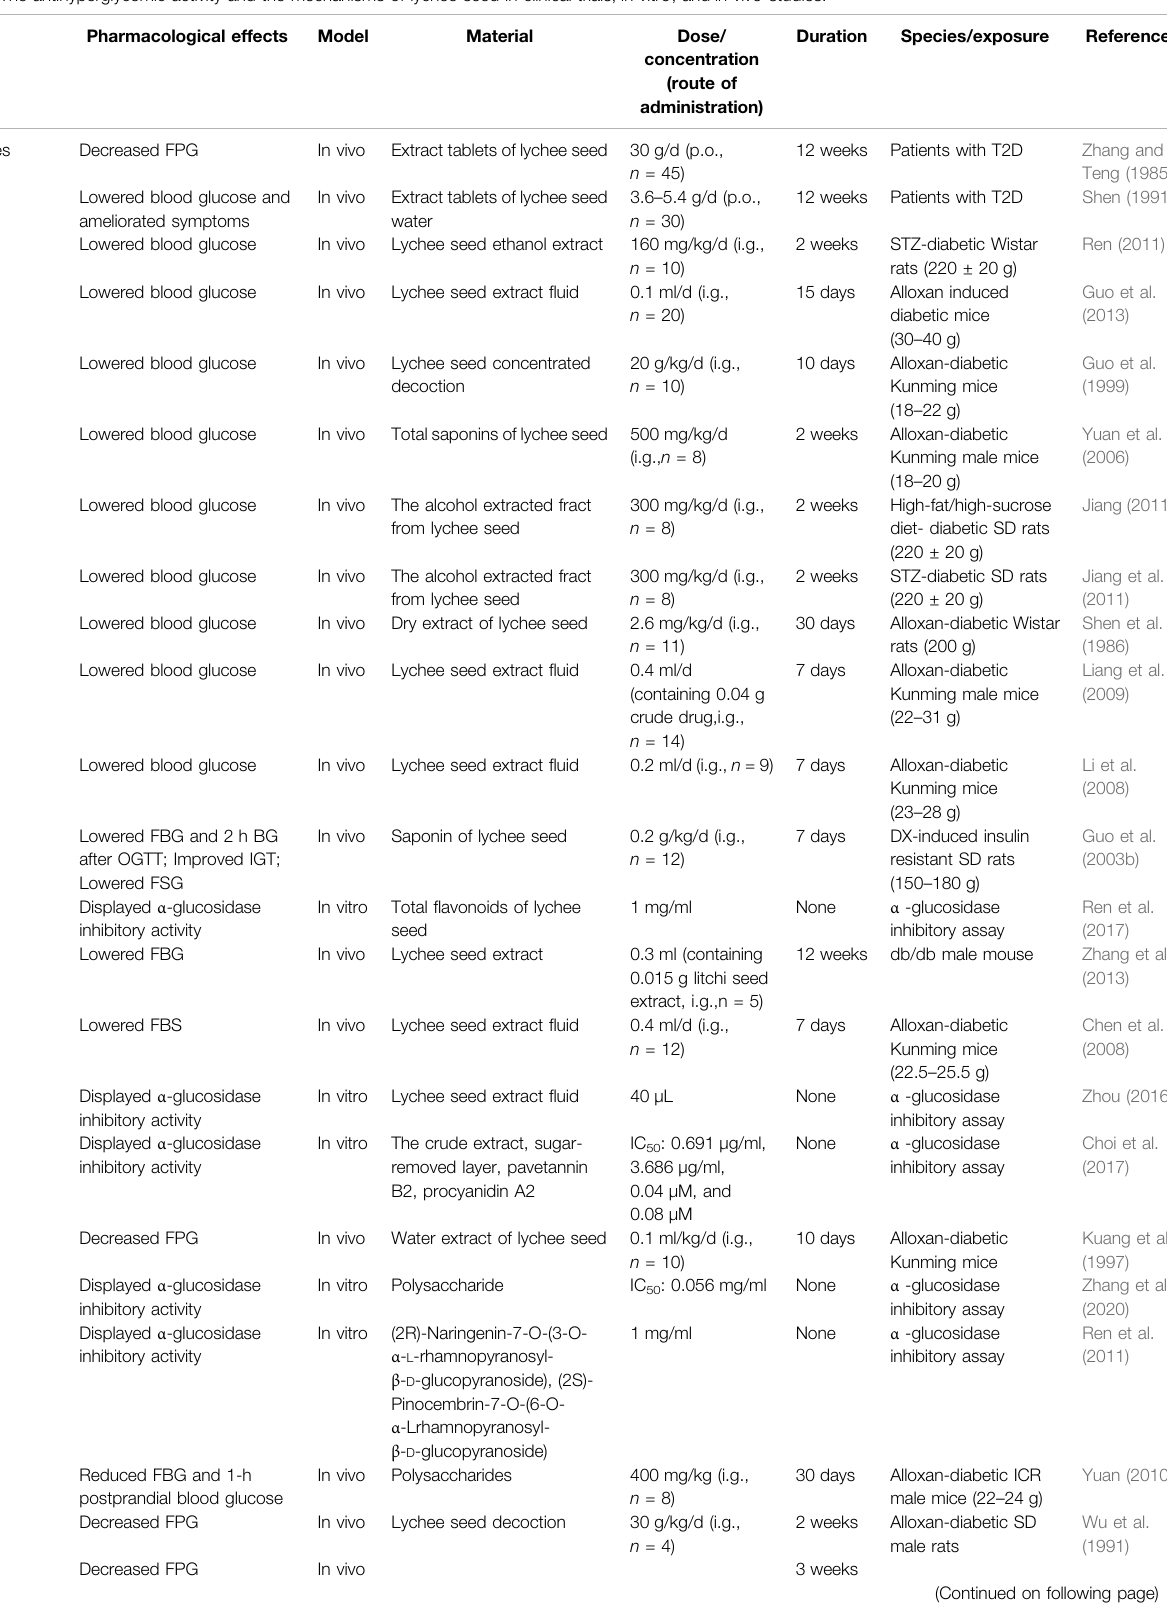
TABLE 1 | The antihyperglycemic activity and the mechanisms of lychee seed in clinical trials, in vitro , and in vivo studies.